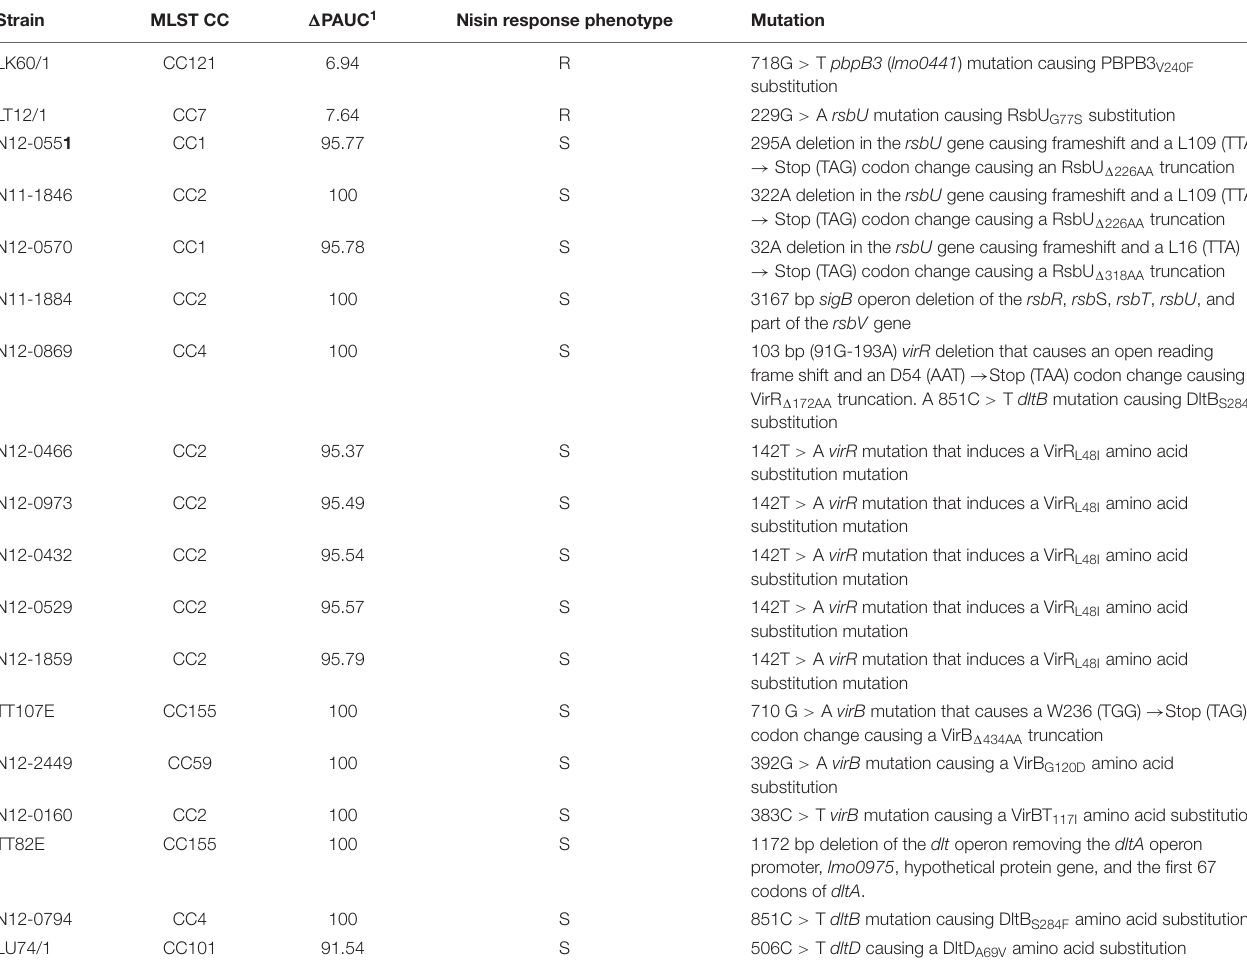
TABLE 1 | Natural nisin resistance gene mutations associated with high nisin resistance ( (cid:49) PAUC < 10%) and sensitivity ( (cid:49) PAUC > 90%) L. monocytogenes field strains. Strain MLST CC